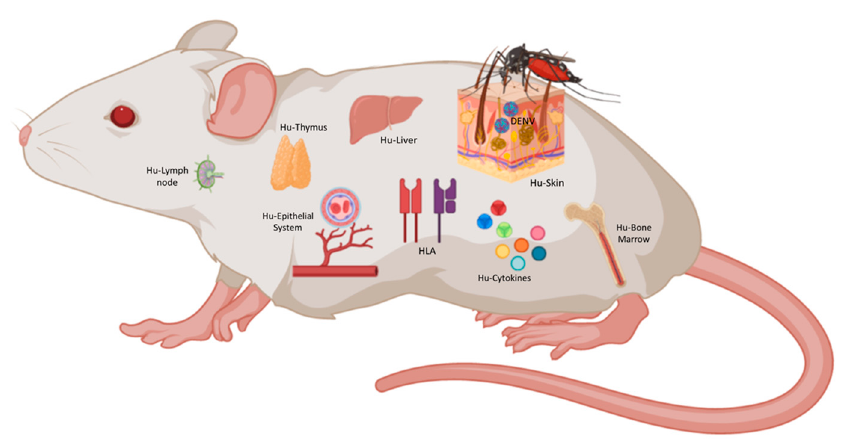
Figure 2. The ideal humanized mouse for DENV. As shown in this figure, an immunocompromise mouse with human HLA and human cytokines background could be transplanted with human skin, human thymus, human CD34+ HSC, and liver hepatocytes generating most of the tissues and cells affected during DENV infection. This figure was created under a paid subscription from